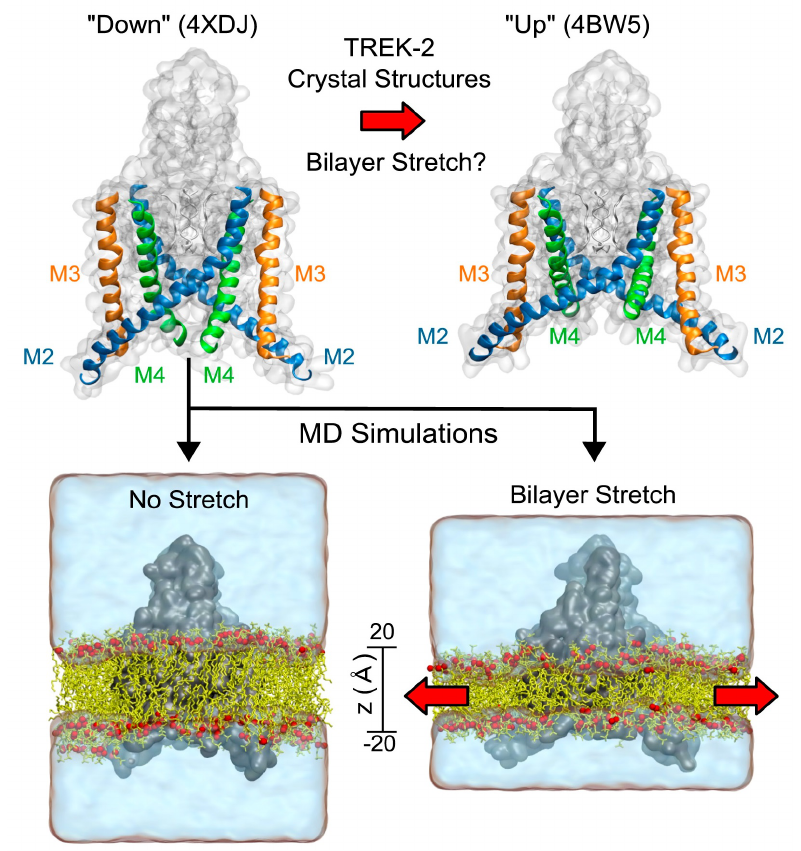
Figure 6. Membrane tension applied to the TREK-2 channel via molecular dynamics simulations. The transmembrane domain modifications induced by lateral membrane tension are shown. When the membrane is not strained, the channel is mostly in the down conformation. When tension is applied to the membrane, the channel moves towards the up conformation. The selectivity filter region, outside of the membrane, is not structurally altered by the applied tension. Adapted from [200] under the CC BY